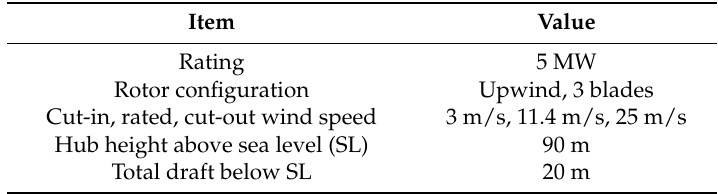
Table 1. Properties of the OC4-DeepCwind